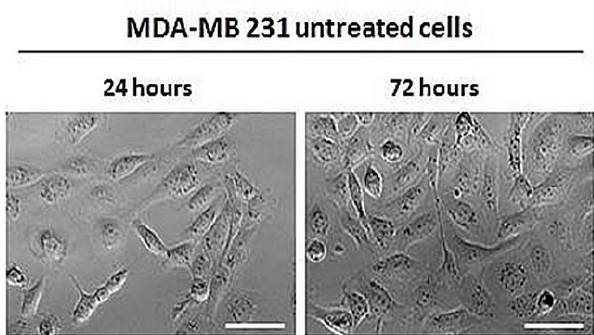
Figure 5. Fields with control cells correspondig to 24 and 72 hours intervals. Images were acquired by a bright field inverted microscope (Olympus IX7), objective 10X, using a CCD video camera COLORVIEW. The scale bar is the same for all images and corresponds to 25 µm.